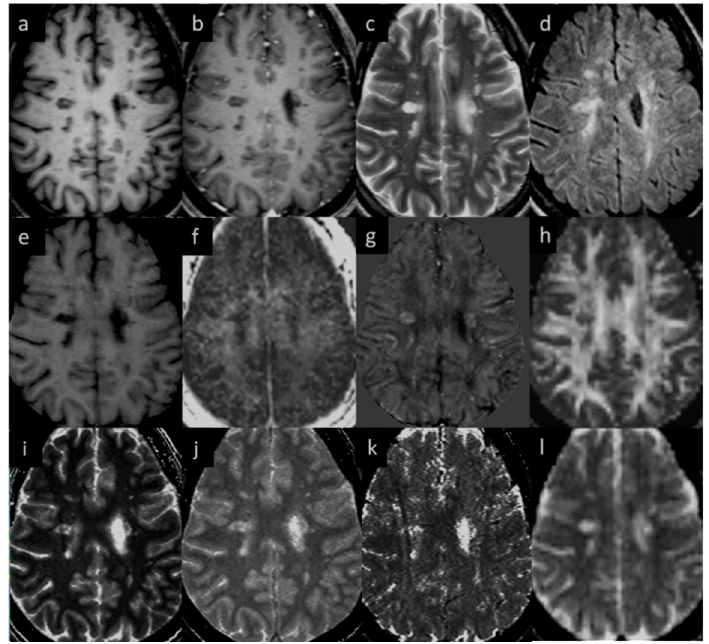
Figure 2. Lesion appearance in different modalities: ( a ) pre-contrast T1W, ( b ) post-contrast T1W, ( c ) T2WI, ( d ) T2 FLAIR, ( e ) MTR, ( f ) MWF, ( g ) QSM, ( h ) FA, ( i ) T1MAP, ( j ) PSDMAP, ( k ) T2STAR, and ( l ) ADC.